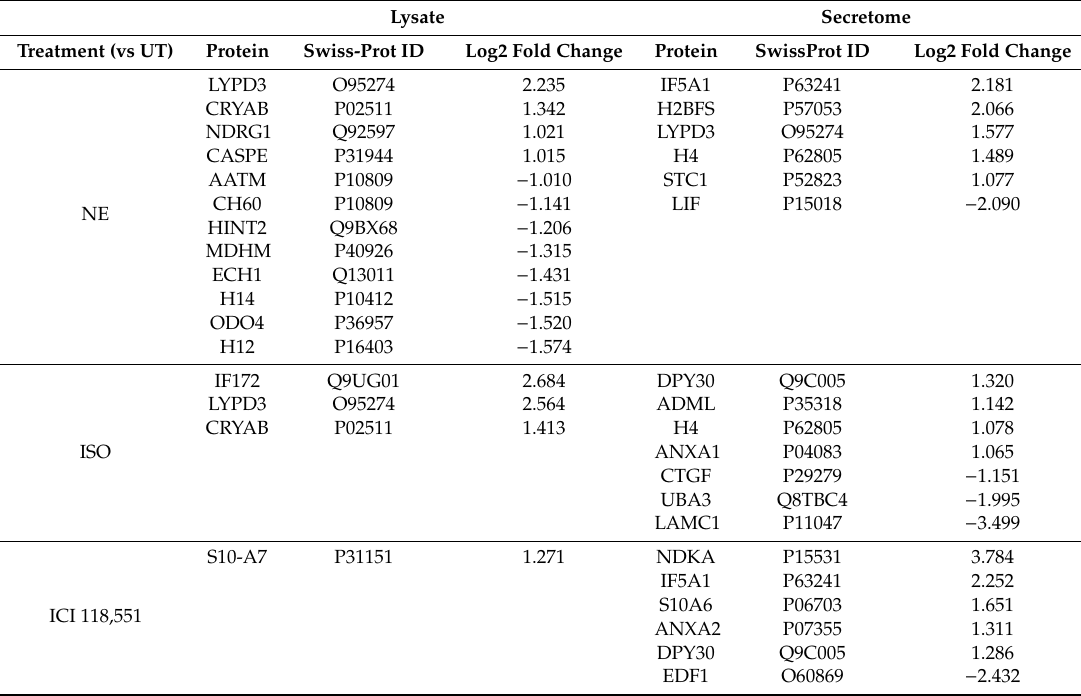
Table 1. Di ff erentially expressed proteins identified using SWATH (Sequential Window Acquisition of All Theoretical Mass Spectra) MS (mass spectrometry) analysis of MDA-MB-468 cell lysate and secretome following adrenoceptor agonism / antagonism.